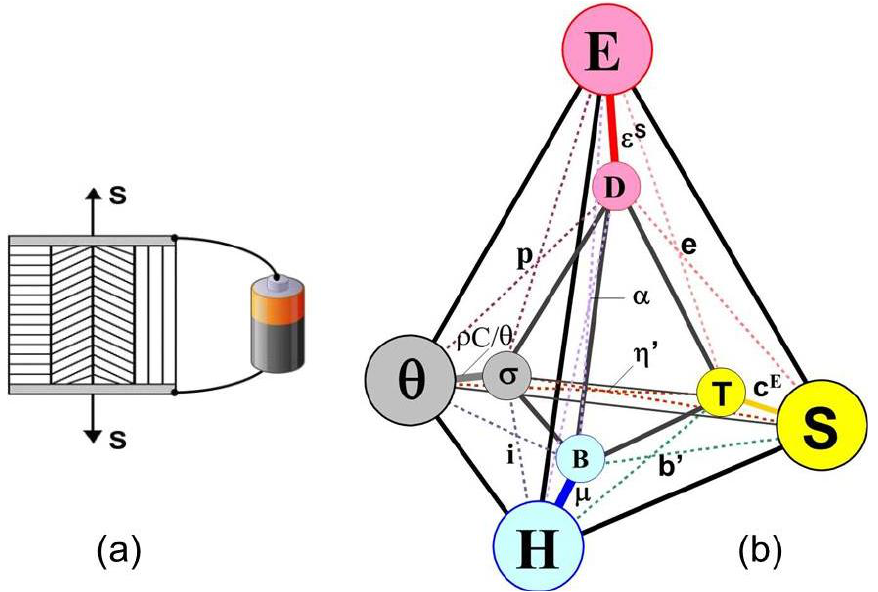
Figure 1. ( a ) A polycrystal in ideal parallel configuration during a (direct or converse) piezoelectric experiment. The actions to be measured are strain and voltage (electric field intensity); ( b ) Graphical representation of principal and coupling interactions. Voigt